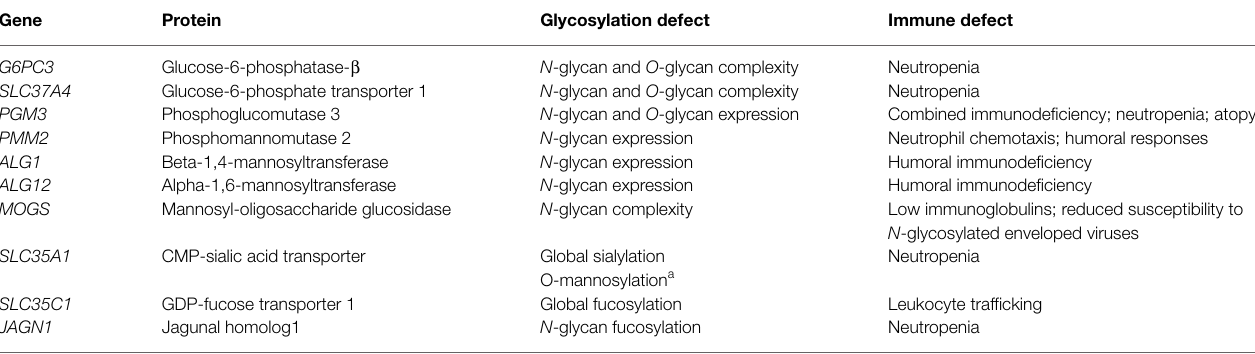
TABLE 1 | Inherited glycosylation defects resulting in immune dysfunction